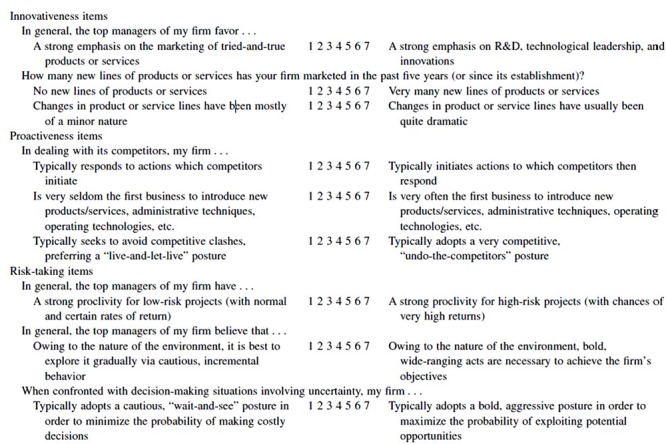
The Covin and Slevin (1989) EO Scale.
Source:
Covin and Wales (2012).